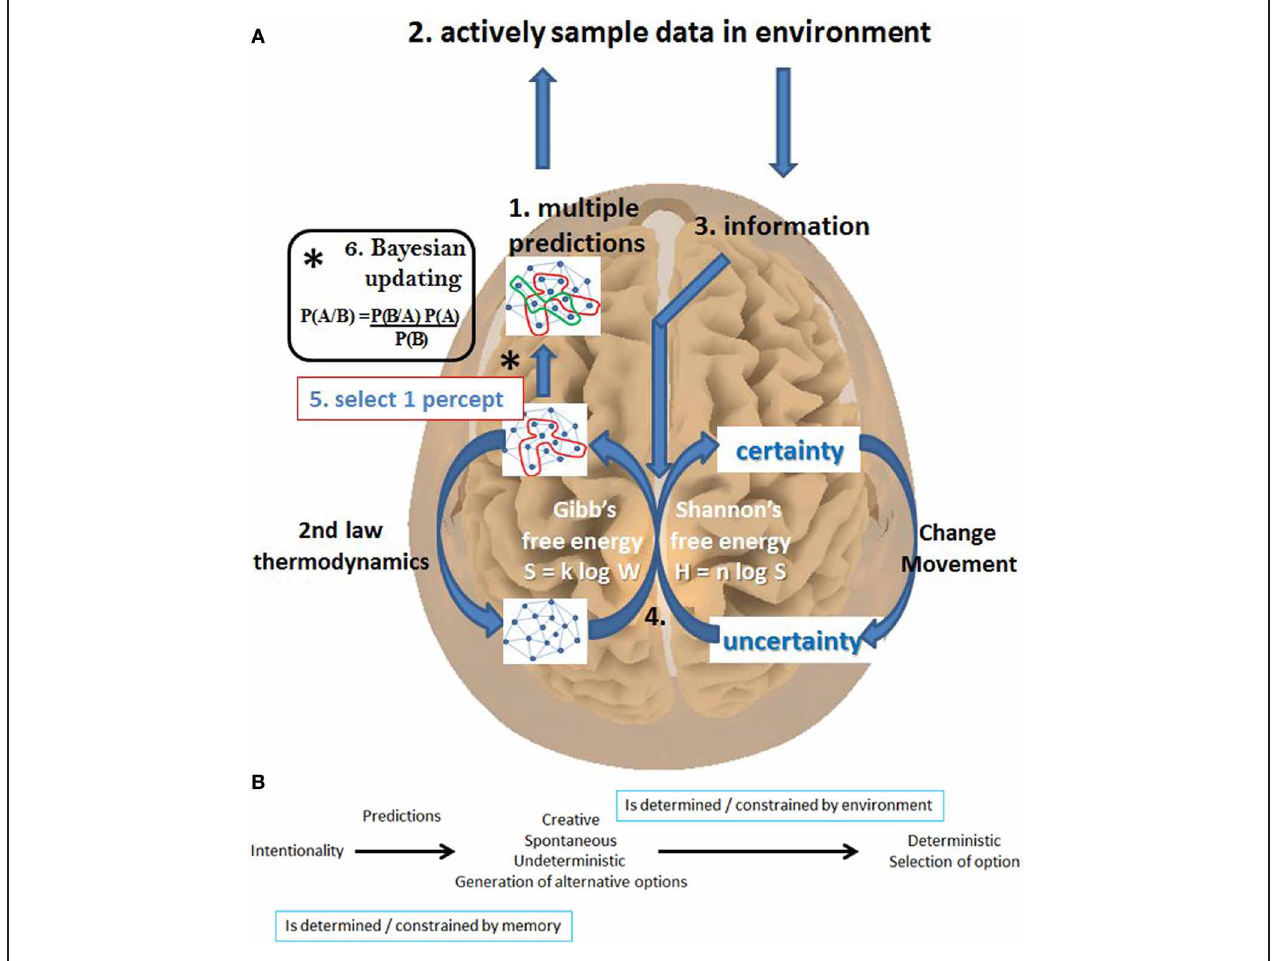
modified from De Ridder et al. (2012). (B) Based on the goal or intention the brain generates multiple possible representations of what to expect in the environment. The representation with the smallest prediction error is selected. However the generation of representations is constrained by what is stored in memory and by the sampling of the